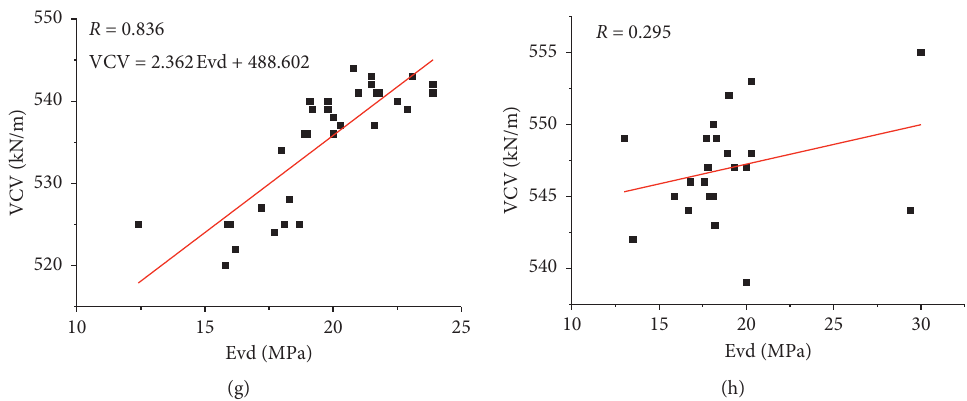
Figure 6: E vd values and their corresponding VCV values among different compaction degrees. (a) WC 1; (b) WC 2; (c) WC 3; (d) WC 4;